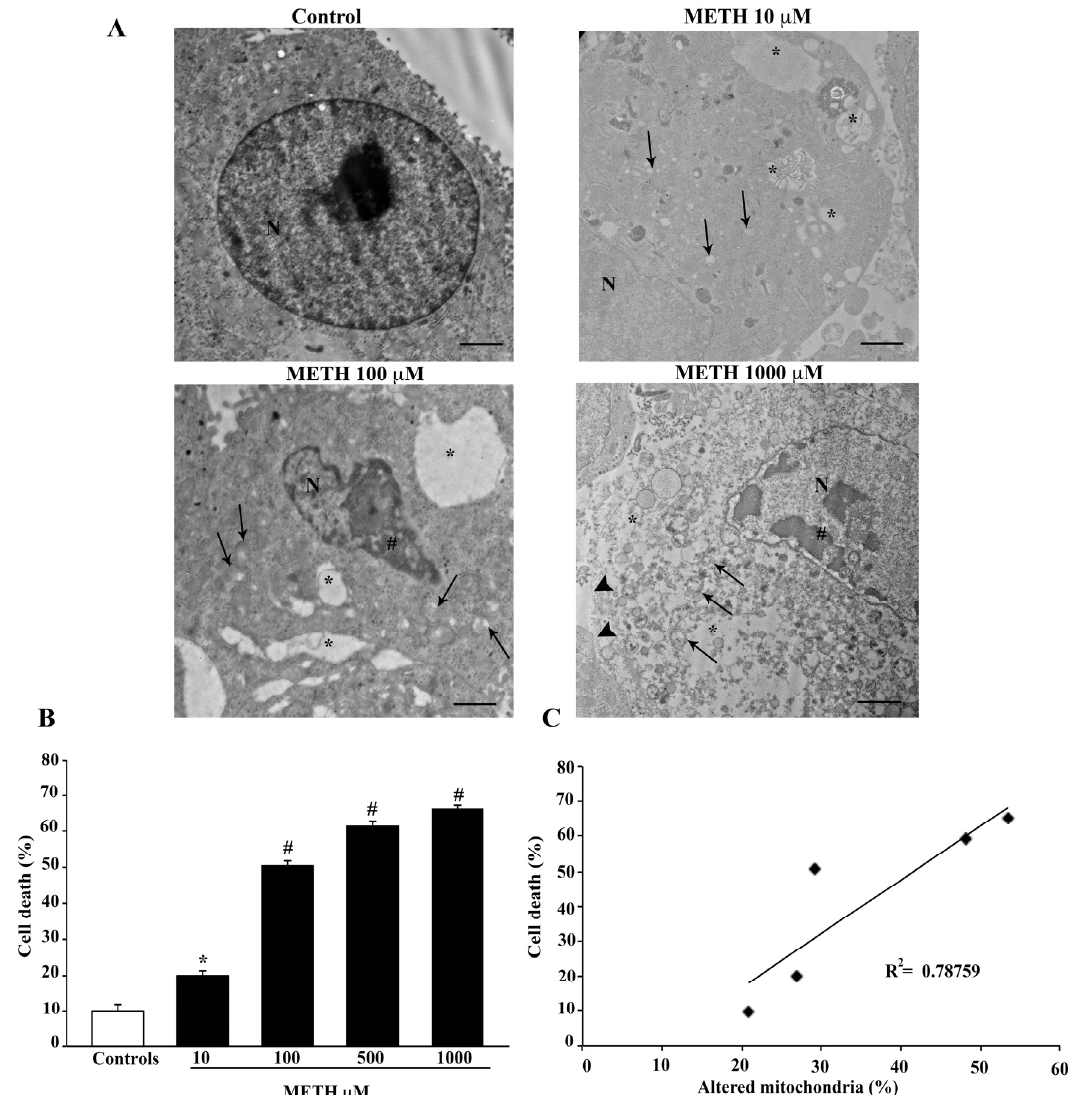
Figure 5. METH-induced cell death correlates with mitochondrial alterations. ( A ) Representative TEM micrographs showing healthy (Control) and damaged cells following increasing doses (10 μ M, 100 μ M, 1000 μ M) of METH. After METH treatment, nuclear condensation (#), large cytosolic vacuoles (*), altered mitochondria (arrows) and fragmentation of plasma membrane (arrowheads) are shown. ( B ) The graph reports the percentage of METH-induced cell death. ( C ) The graph reports the linear regression between the percentage of cell death and the percentage of altered mitochondria following increasing doses of METH ( p = 0.04). Values are given as the mean percentage ± S.E.M. from N = 100 cells. * p ≤ 0.05 compared with controls; # p ≤ 0.05 compared with controls and METH 10 μ M. Scale bars = 700 nm. N = nucleus.